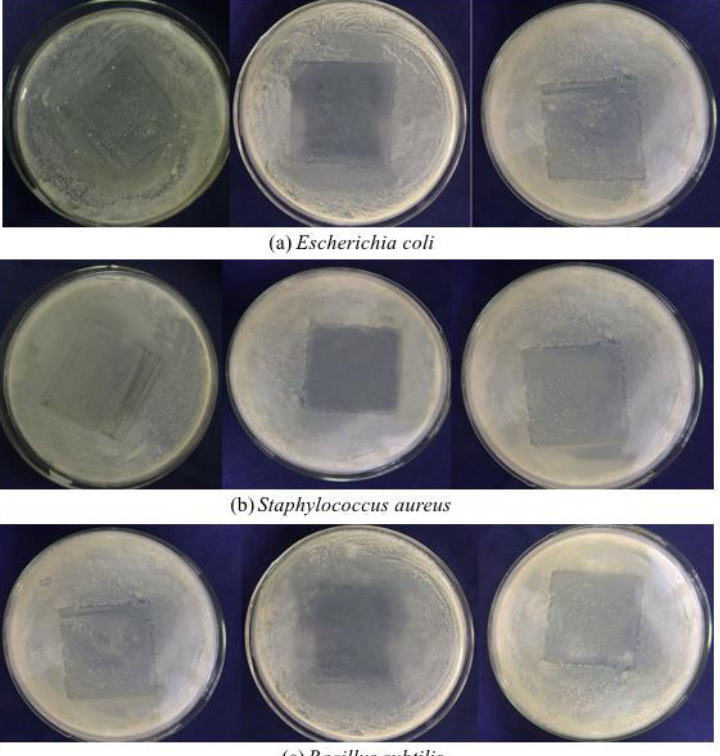
Figure 5. Results of the measurement of the antimicrobial ability of the microcapsule films : ( a ) Esch- erichia coli ; ( b ) Staphylococcus aureus ; ( c ) Bacillus subtilis . (the contact surfaces of the microcapsule films and the culture medium from left to right are: blank films, the front surface of the microcapsule films, and the bottom surface of the microcapsule films)